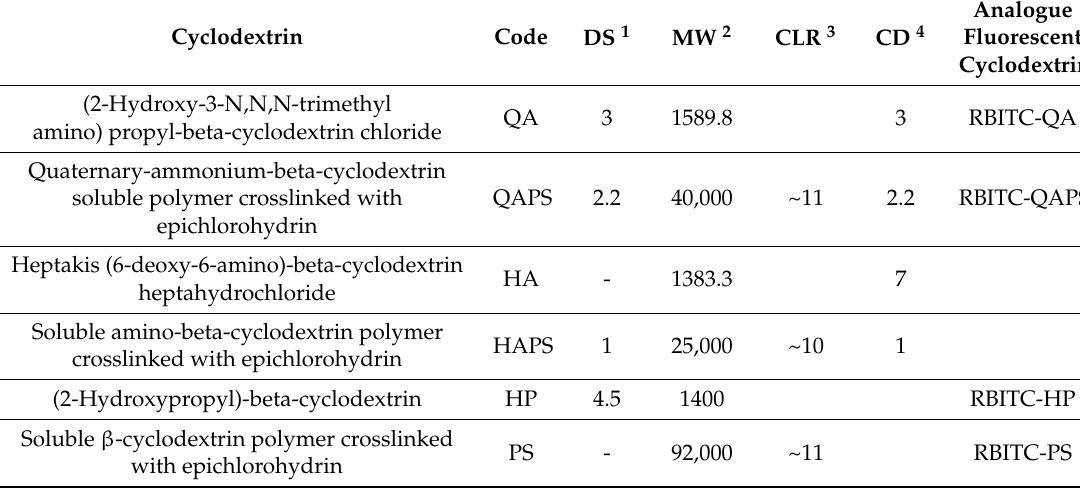
Table 1. Description of beta-cyclodextrin monomers and polymers studied in this work. Cyclodextrin Code DS 1 MW 2 CD 4 (2-Hydroxy-3-N,N,N-trimethyl